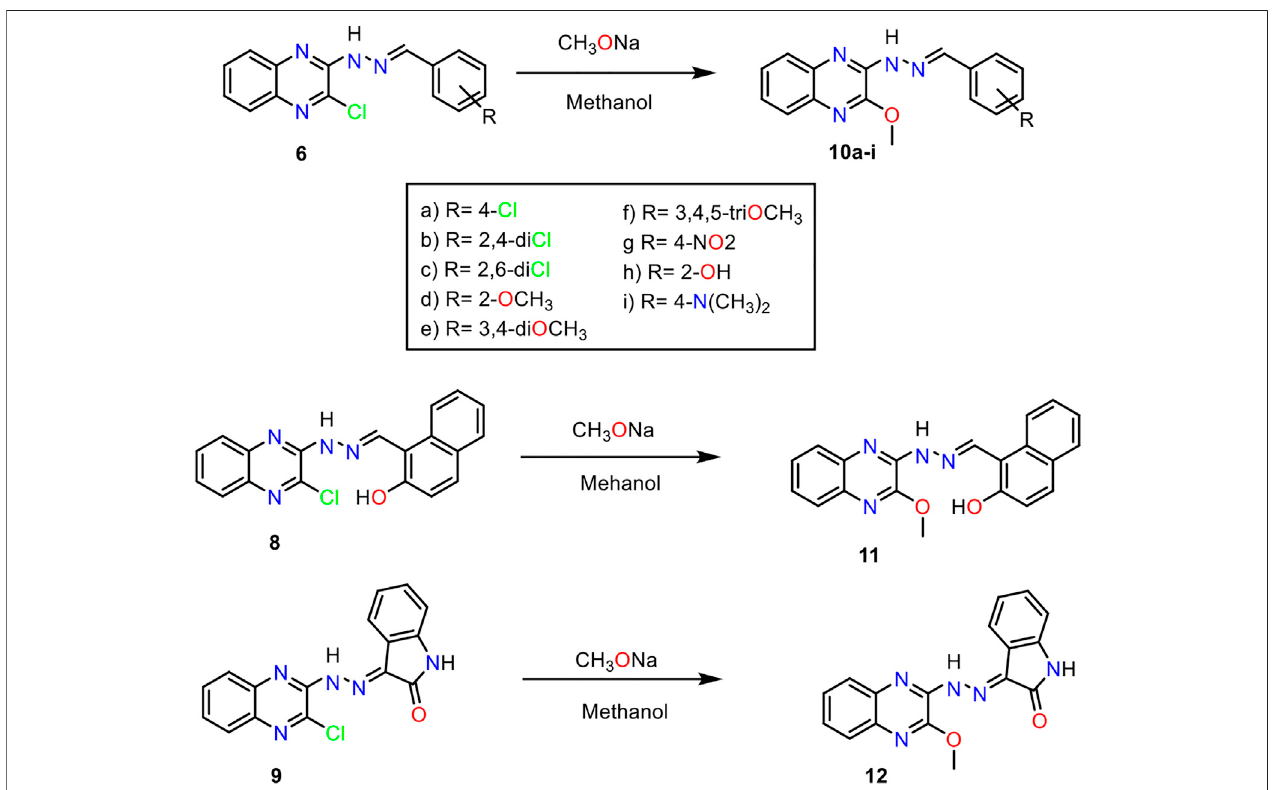
Scheme 2 | General procedure for the synthesis of compounds 10 a-i , 11 , and 12